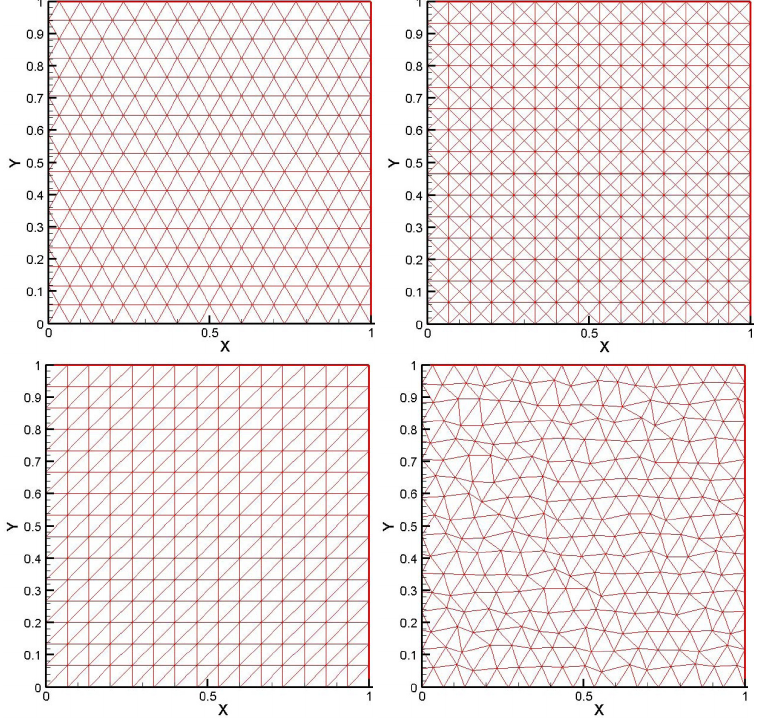
Figure 2. Representative grid types: Equilateral, Orthogonal I, Orthogonal II, Distorted (left to right).